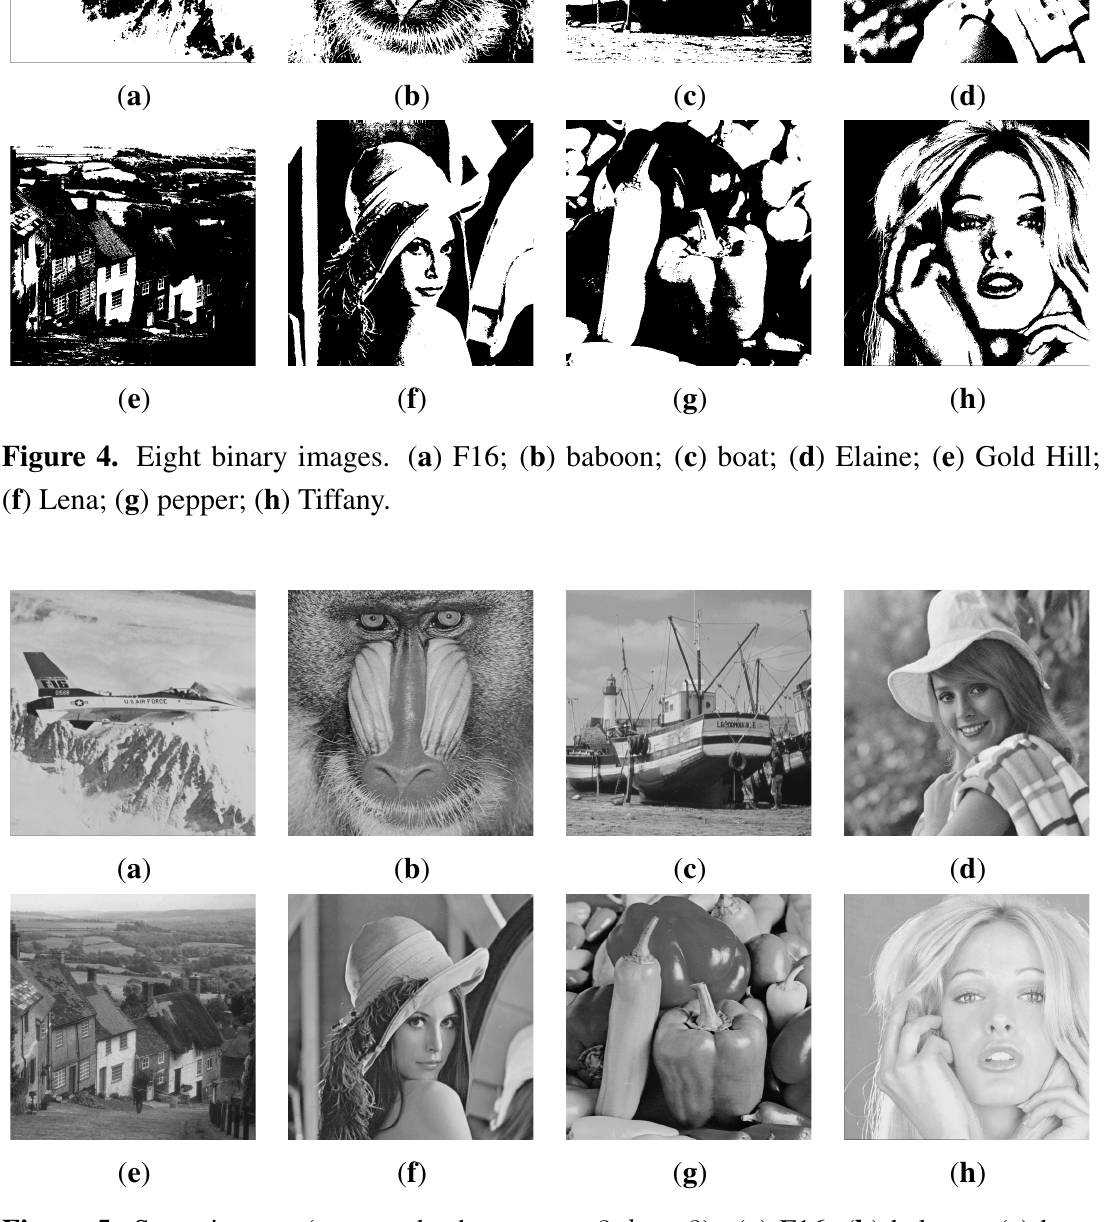
Figure 5. Stego images (proposed scheme n = 3 , k = 3 ). ( a ) F16; ( b ) baboon; ( c ) boat; ( d ) Elaine; ( e ) Gold Hill; ( f ) Lena; ( g ) pepper; ( h )